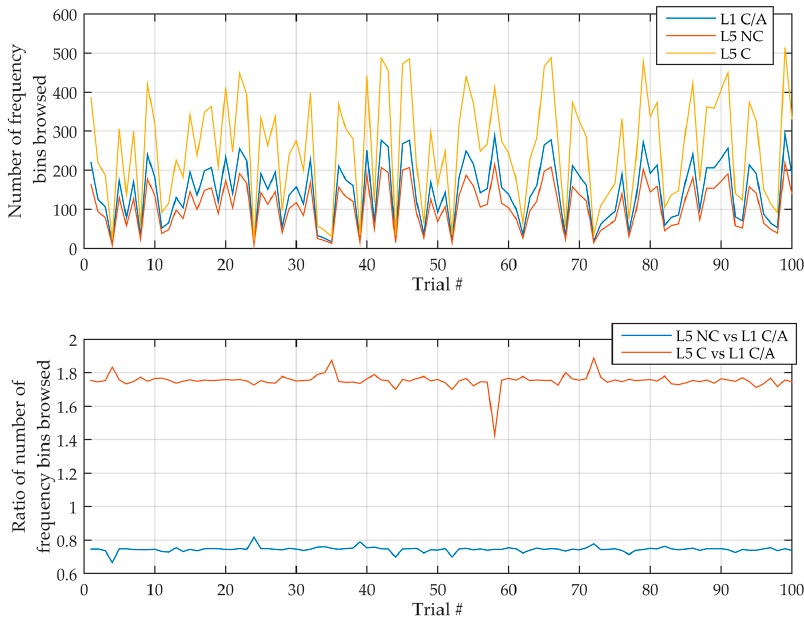
Figure 13. Number of frequency bins browsed ( top ) and ratio ( bottom ) of this over 100 simulations, for a sensitivity of − 145 dBm without assistance. Table 13. Theoretical and average of the measured number of frequency bins and their ratio between L5 and L1.